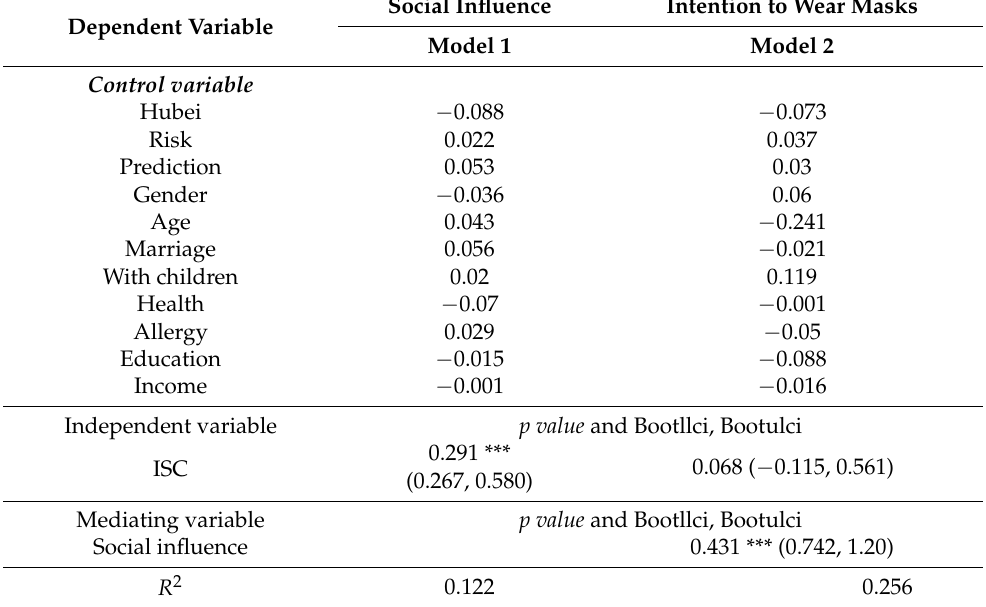
Table 4. Mediation effect